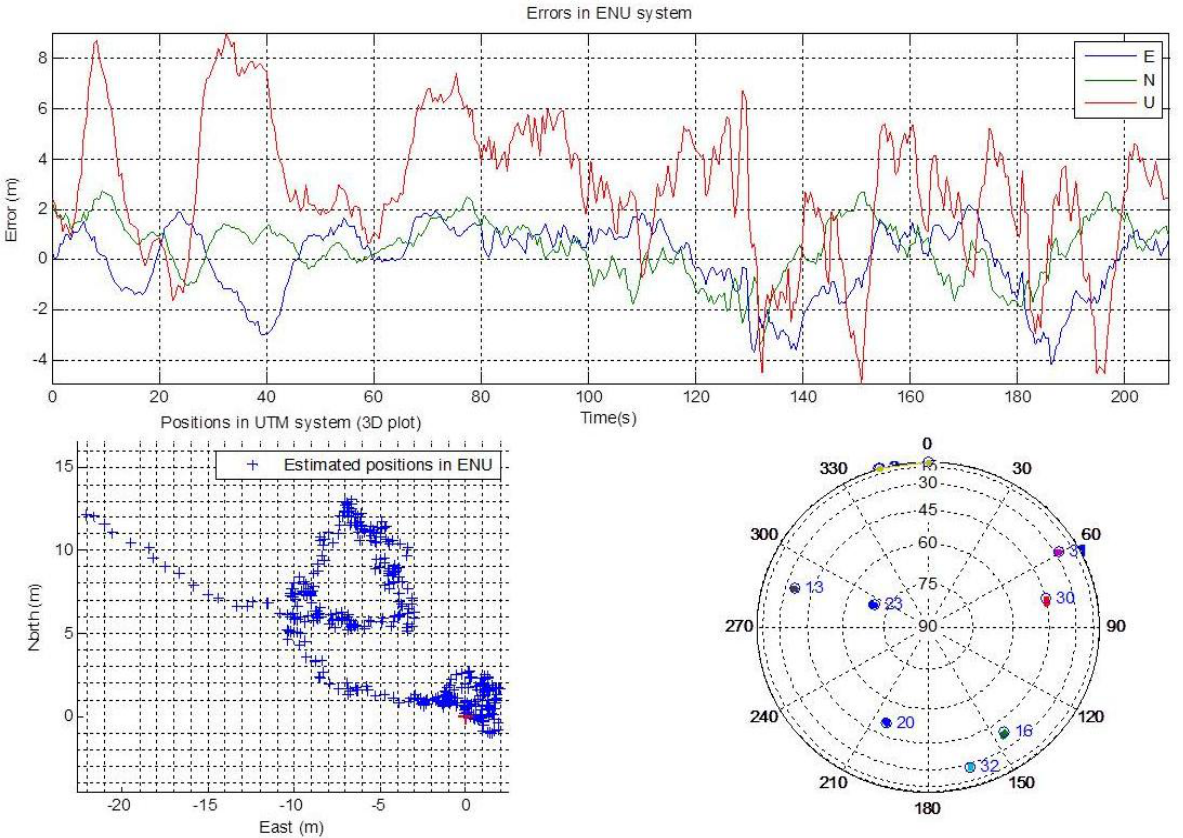
Figure 6. Estimated position solutions and the corresponding errors by the software